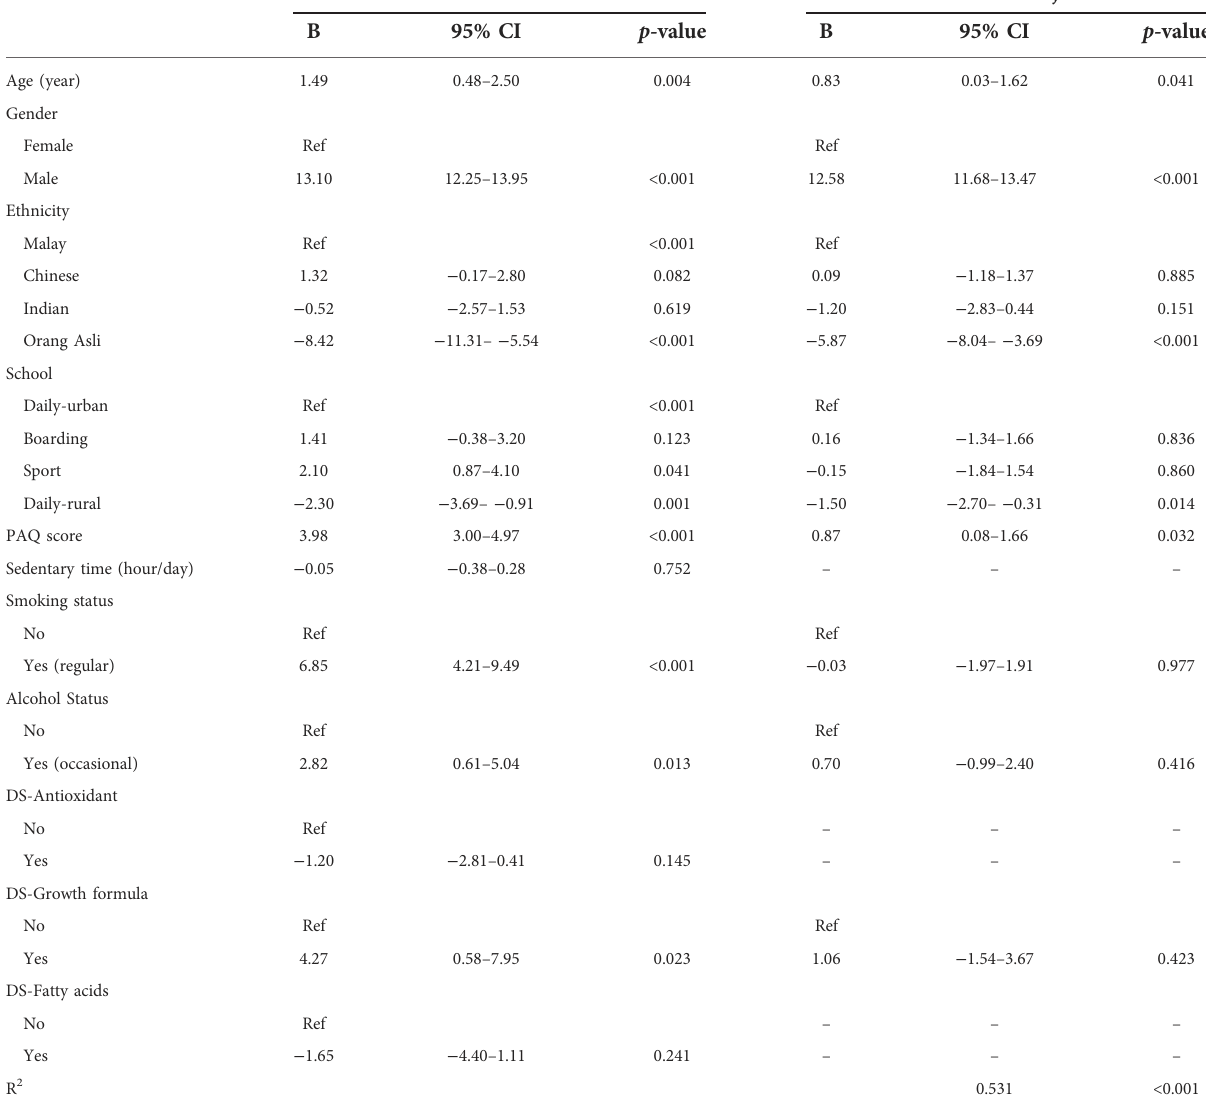
TABLE 5 Linear regression analyses for factors associated with lean mass ( n